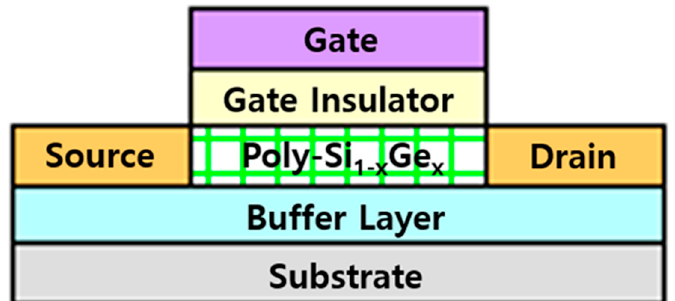
Figure 1. The schematic structure of the thin-film transistor (TFT) with polycrystalline silicon–germanium (poly-Si 1 − x Ge x ) as an active layer.